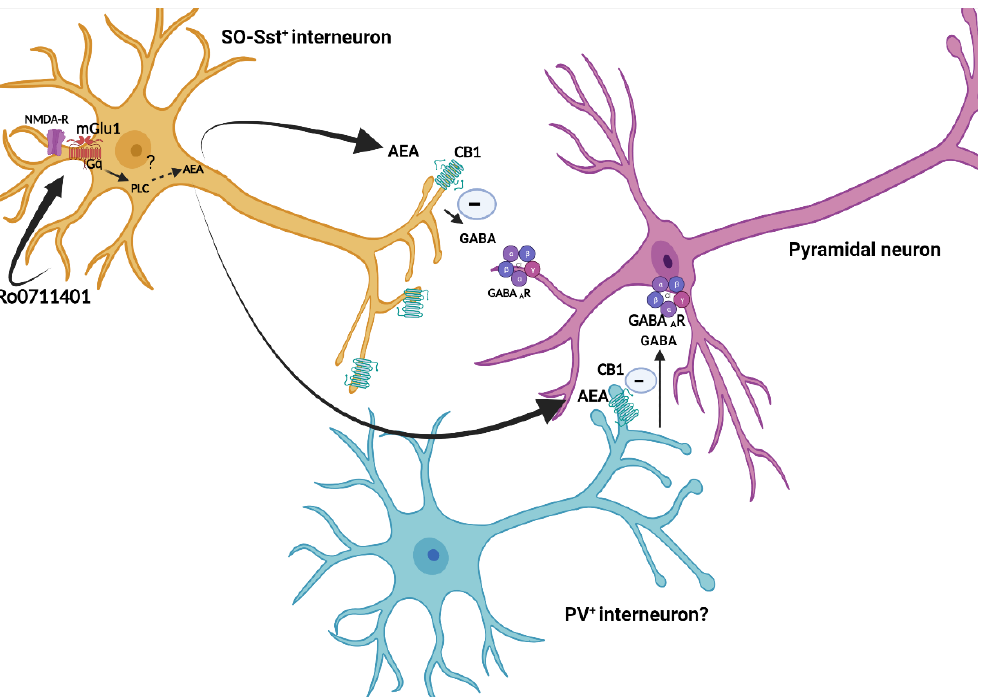
Figure 7. Hypothetical mechanism of Ro0711401-induced learning and memory improvement in SCA1 mice model. Selective pharmacological activation of mGlu1 receptors in stratum oriens somatostatin-positive interneurons (SO-sst + interneurons) enhances anandamide production through a non-conventional synthetic pathway that may involve G q -mediated PLC-β activation. Activation of CB1 receptors in nerve terminals of somatostatin-positive interneurons or other interneurons causes inhibition of GABA release with ensuing activation of pyramidal neurons. A similar scenario has been proposed by Landucci et al., 2022 [62]. Created with BioRender.com.